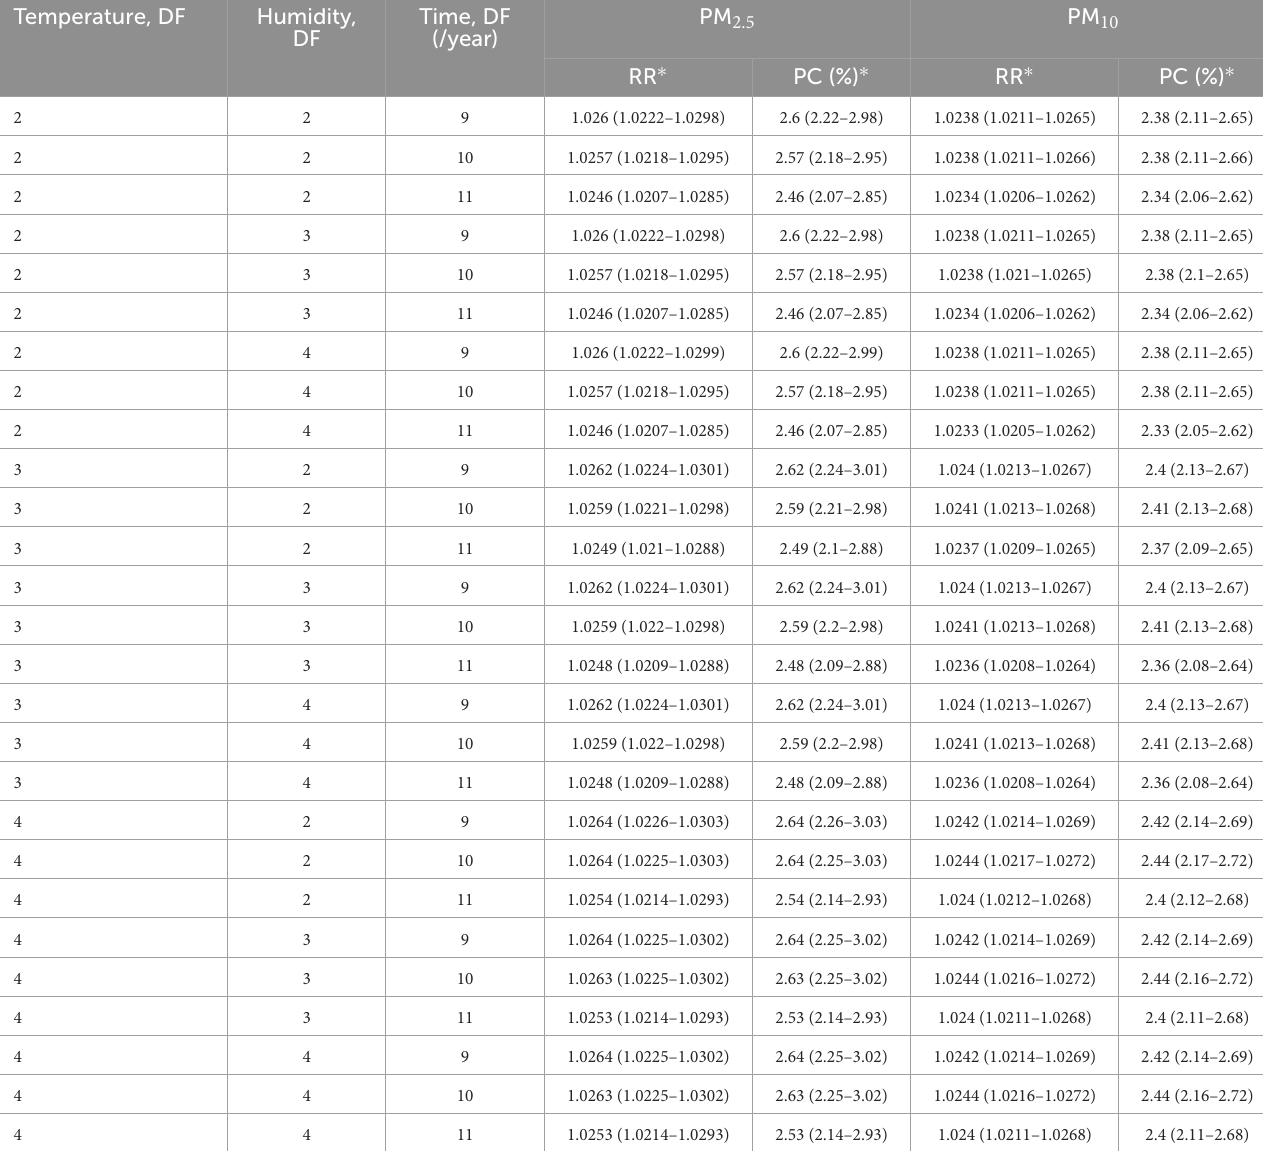
TABLE 8 The RR and percent change of eczema risk associated with 10 mg/m 3 increase of PM 2.5 and PM 10 with different degrees of freedom. Temperature,